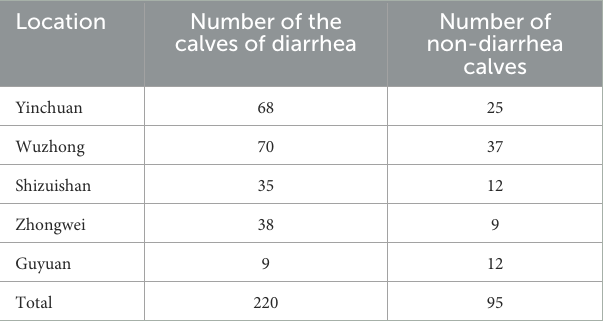
Number of non-diarrhea